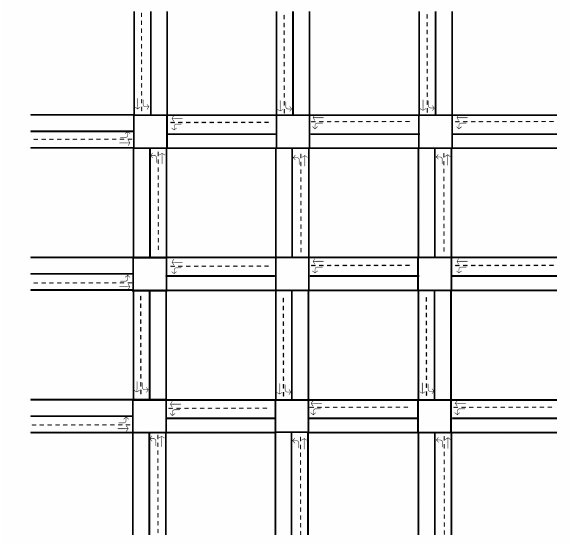
Figure 8. Structure of the experiment environment: nine